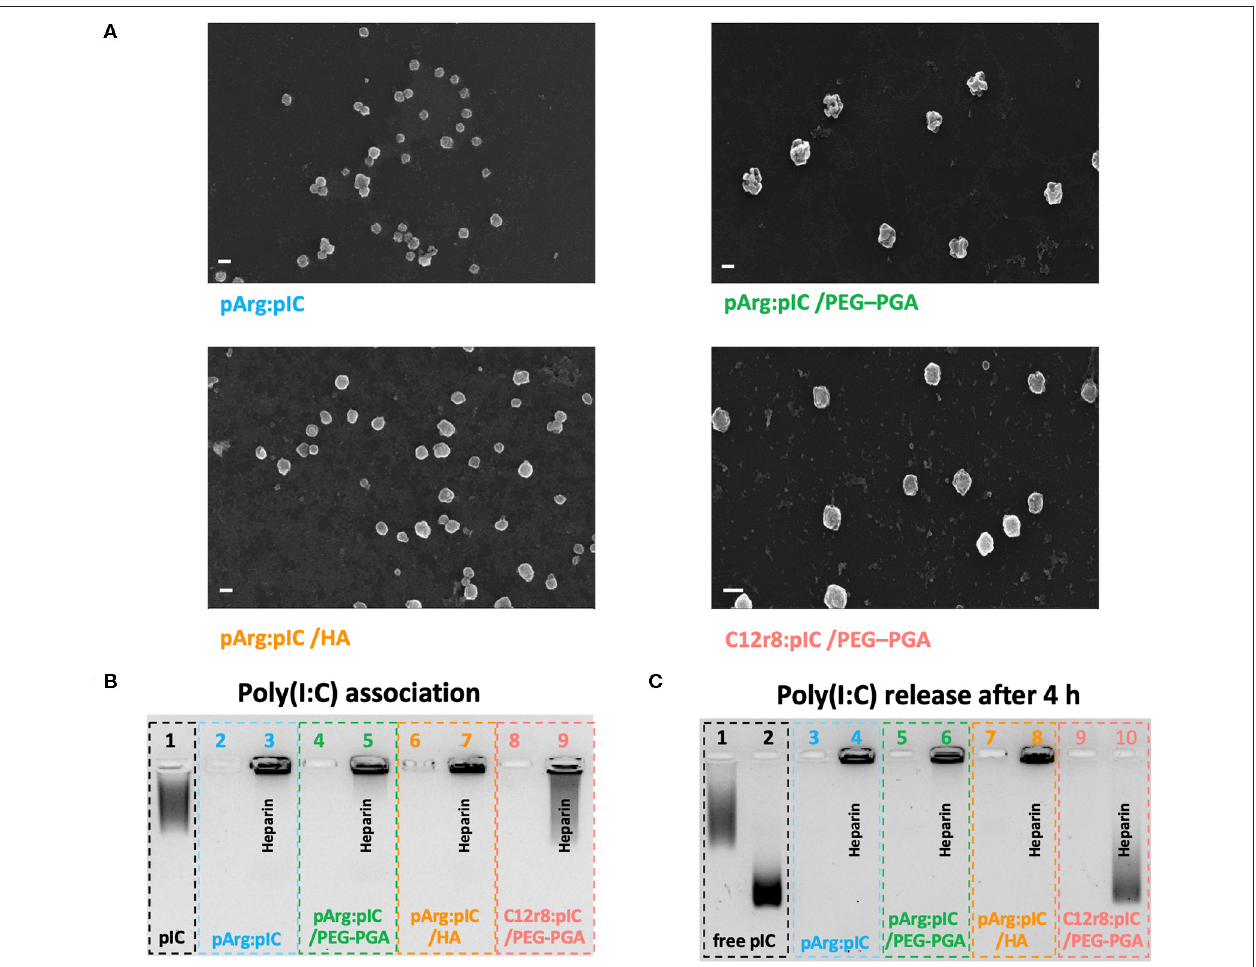
FIGURE 2 | Physicochemical properties and poly(I:C) binding affinity of the selected nanocomplexes. (A) FESEM images of each of the four developed nanosystems. Values represent mean ± SD ( n ≥ 12). Size bars represent 200nm, and all images present a 50K magnification. (B) Agarose gel retardation assay to evaluate the poly(I:C) binding capacity of the nanocomplexes. Lanes: (1) free poly(I:C), (2,4,6,8) are pArg:pIC, pArg:pIC/PEG–PGA, pArg:pIC/HA and C12r8:pIC/PEG–PGA nanocomplexes, respectively; and (3,5,7,9) are the corresponding nanocomplexes incubated with heparin. (C) Agarose gel retardation assay to evaluate the release and integrity of poly(I:C) after 4h of incubation in cell culture media at 37 ◦ C. Lanes: (1) free poly(I:C) in solution and (2) in cell culture media; (3,5,7,9) are pArg:pIC, pArg:pIC/PEG–PGA, pArg:pIC/HA and C12r8:pIC/PEG–PGA nanocomplexes in cell culture media; and (4,6,8,10) are the same conditions incubated with heparin. C12r8, laurate-octaarginine; FESEM, field emission scanning electron microscopy; HA, hyaluronic acid; pArg, poly-arginine; PEG–PGA, pegylated polyglutamic acid; PDI, polydispersity index; pIC, poly(I:C); w/w,